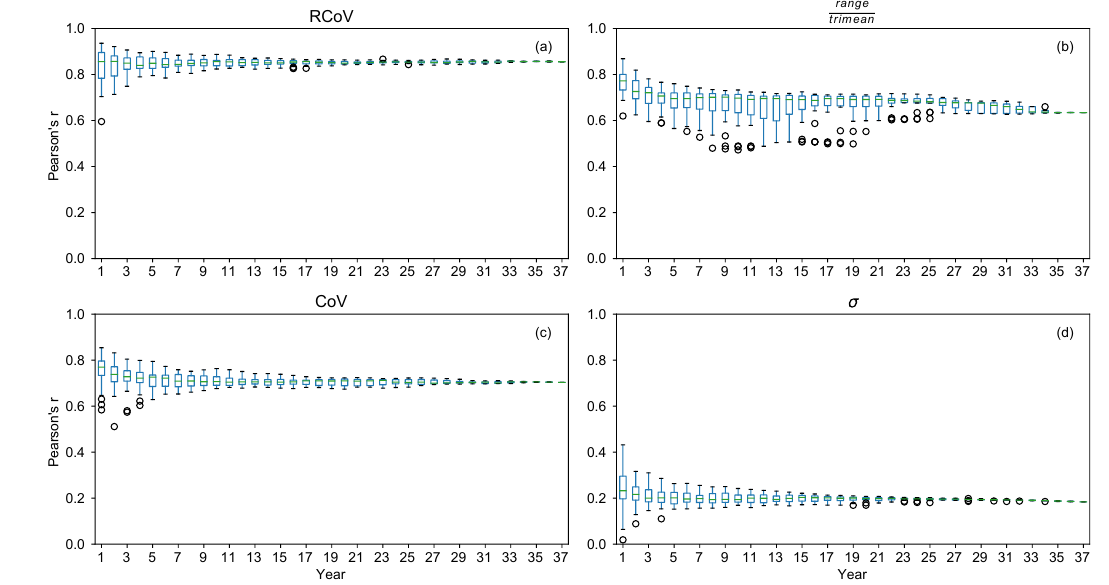
Figure 5. Box plots of Pearson’s r between wind-speed variability and energy variability for different analysis time frames, from 1 to 37 years: (a) RCoV, (b) range , (c) CoV, and (d) σ , based on the monthly data from the 195 r -filtered wind sites. Each r represents the trimean correlation using all the filtered sites of a particular time frame. The 37-year correlations are equal to the r values listed in Fig. 4. The box and whiskers represent the third quartile plus the 1.5 times of interquartile range (IQR), the third quartile, the median, the first quartile, and the first quartile minus the 1.5 times of